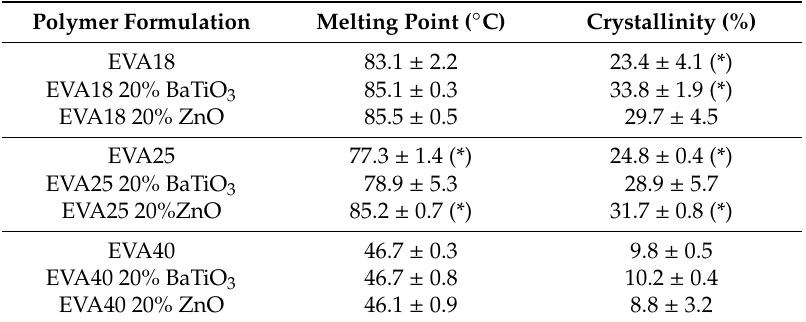
Table 2. Di ff erential Scanning Calorimetry (DSC) analysis on the di ff erent material formulations. Table 2. Differential Scanning Calorimetry (DSC) analysis on the different material formulations. Statistical di ff erences are defined by p -value > 0.05 (*) in each EVA Statistical differences are defined by p -value > 0.05 (*) in each EVA subgroup.